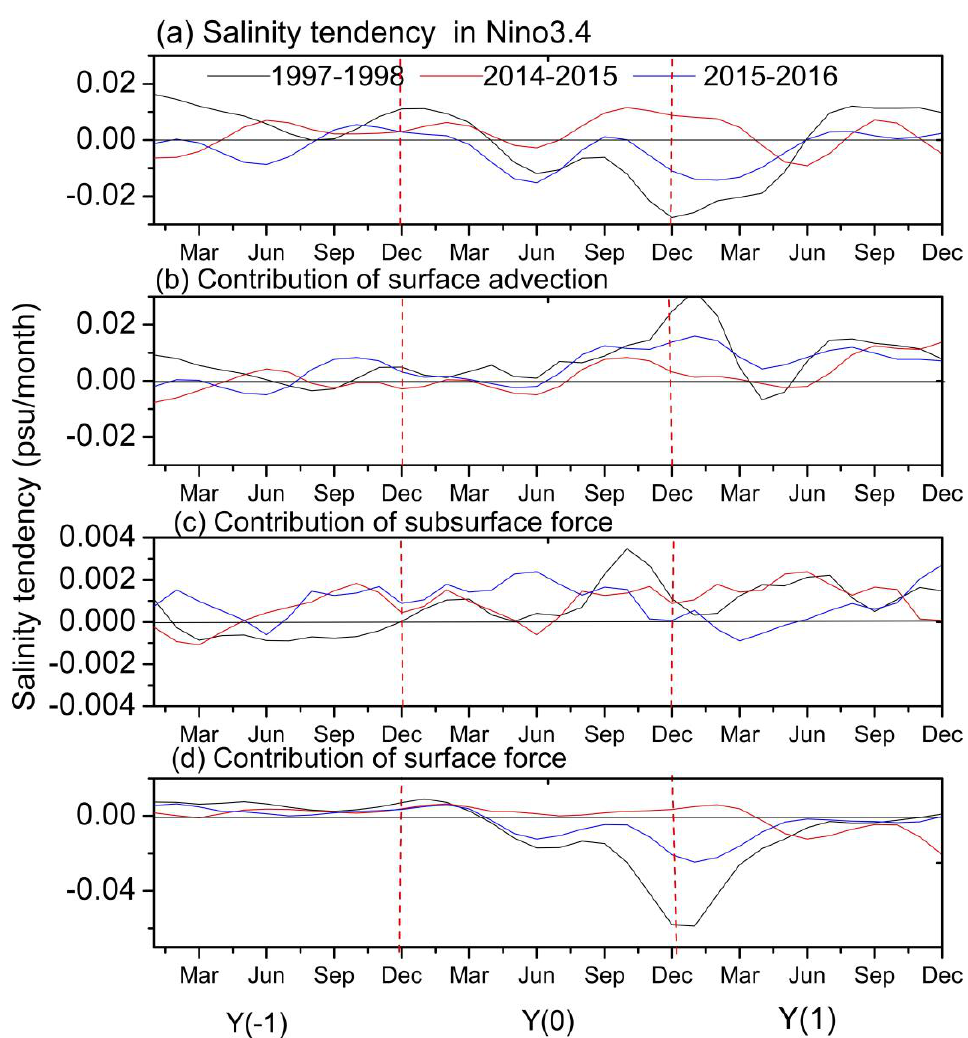
Figure 8. Contribution of MLS budget terms for ENs in 1997–1998 (black), 2014–2015 (red) and 2015–2016 (blue) for ( a ) salinity tendency, and salinity budget terms ( b ) surface advection, ( c ) subsurface force, and ( d ) surface force in Niño 3.4 box. The horizontal black line represents zero. The units for budget terms are psu/day.